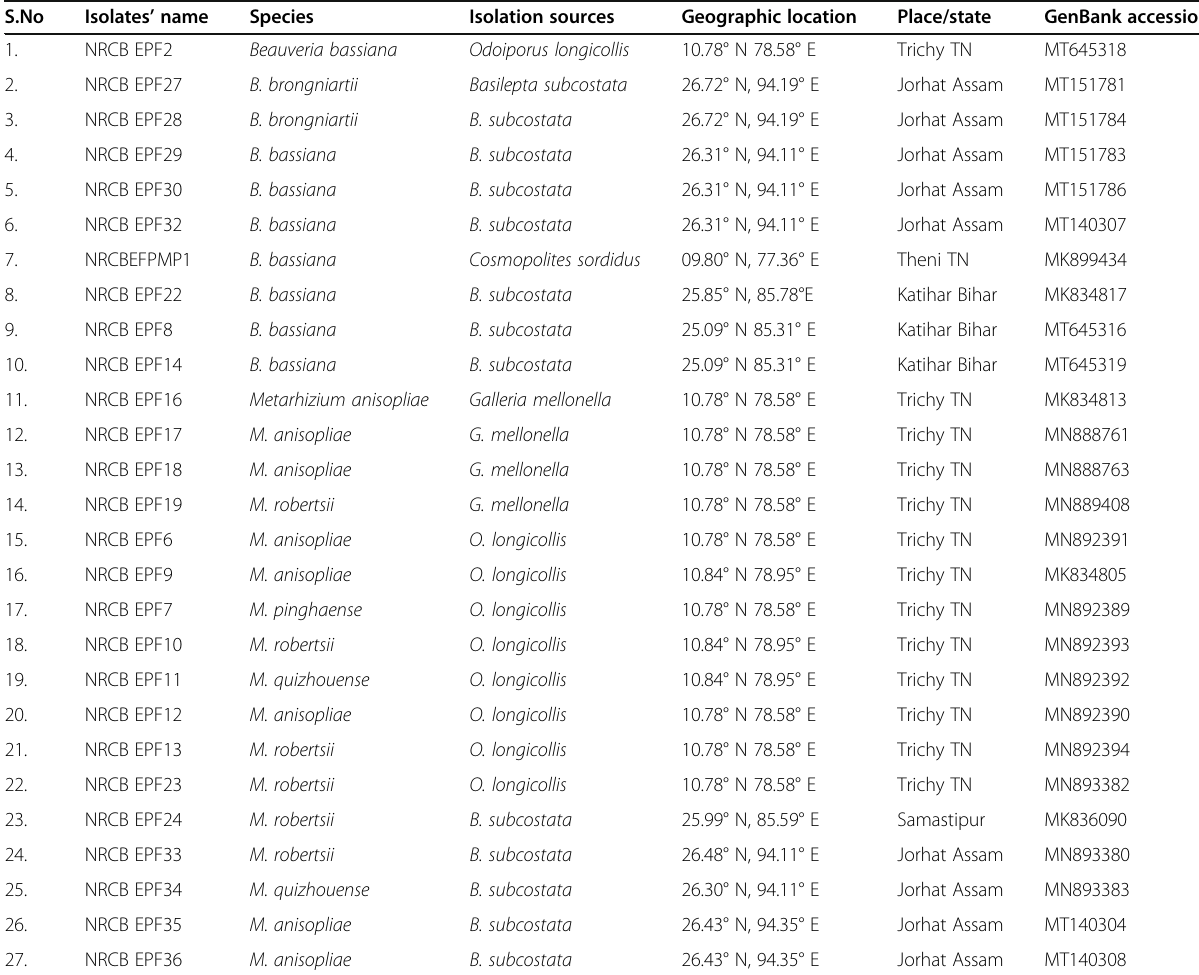
Table 1 Entomopathogenic fungal isolates obtained from different banana pests and Galleria mellonella and their identity